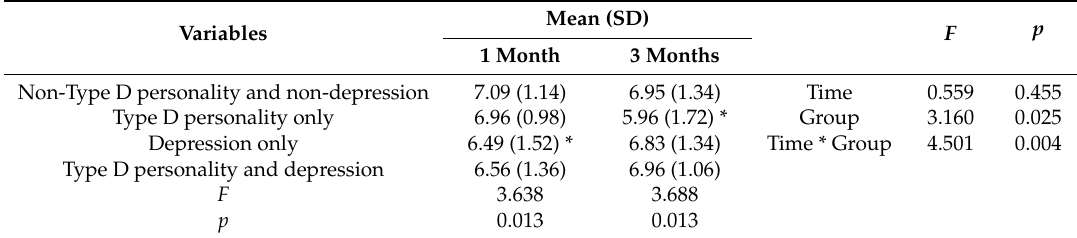
Table 3. Mean score for medication adherence by Type D personality and depression at baseline.